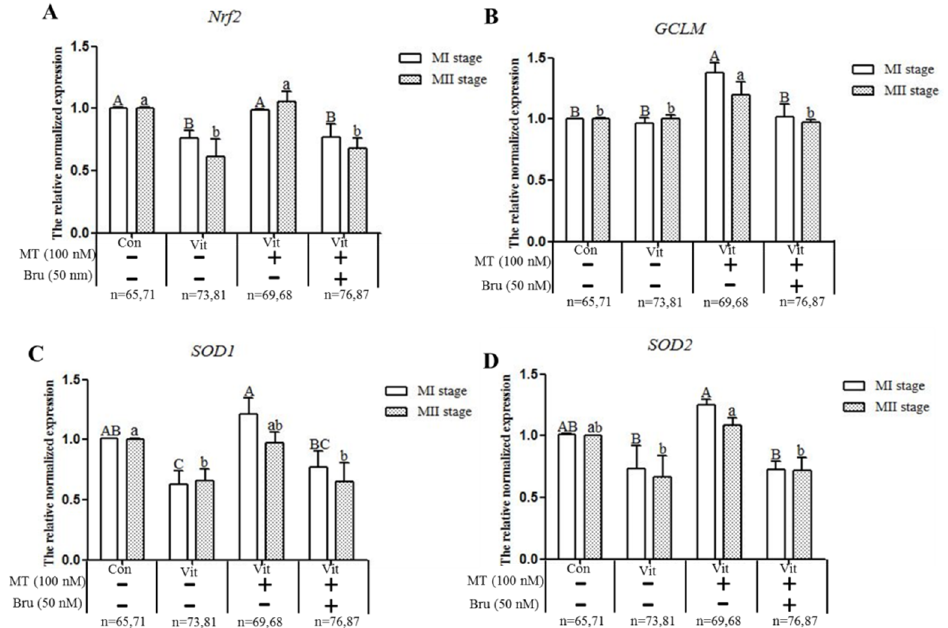
Figure 6. Effects of melatonin (MT) and Brusatol (Bru) on expression of Nrf2 pathway-related antioxidant genes during in vitro maturation of vitrified-warmed GV mouse oocytes. Data are presented as mean ± SEM of three independent experiments. Values with different superscripts A (a), B (b), and C (c) are different ( p < 0.05) between groups at the same stages. Scale bar = 50 µm. The four experimental groups: control (Con), vitrification (Vit), vitrification+ melatonin (Vit + MT), and vit- rification + melatonin + Brusatol (Vit + MT + Bru). Notes: MI: metaphase I; MII: metaphase II.